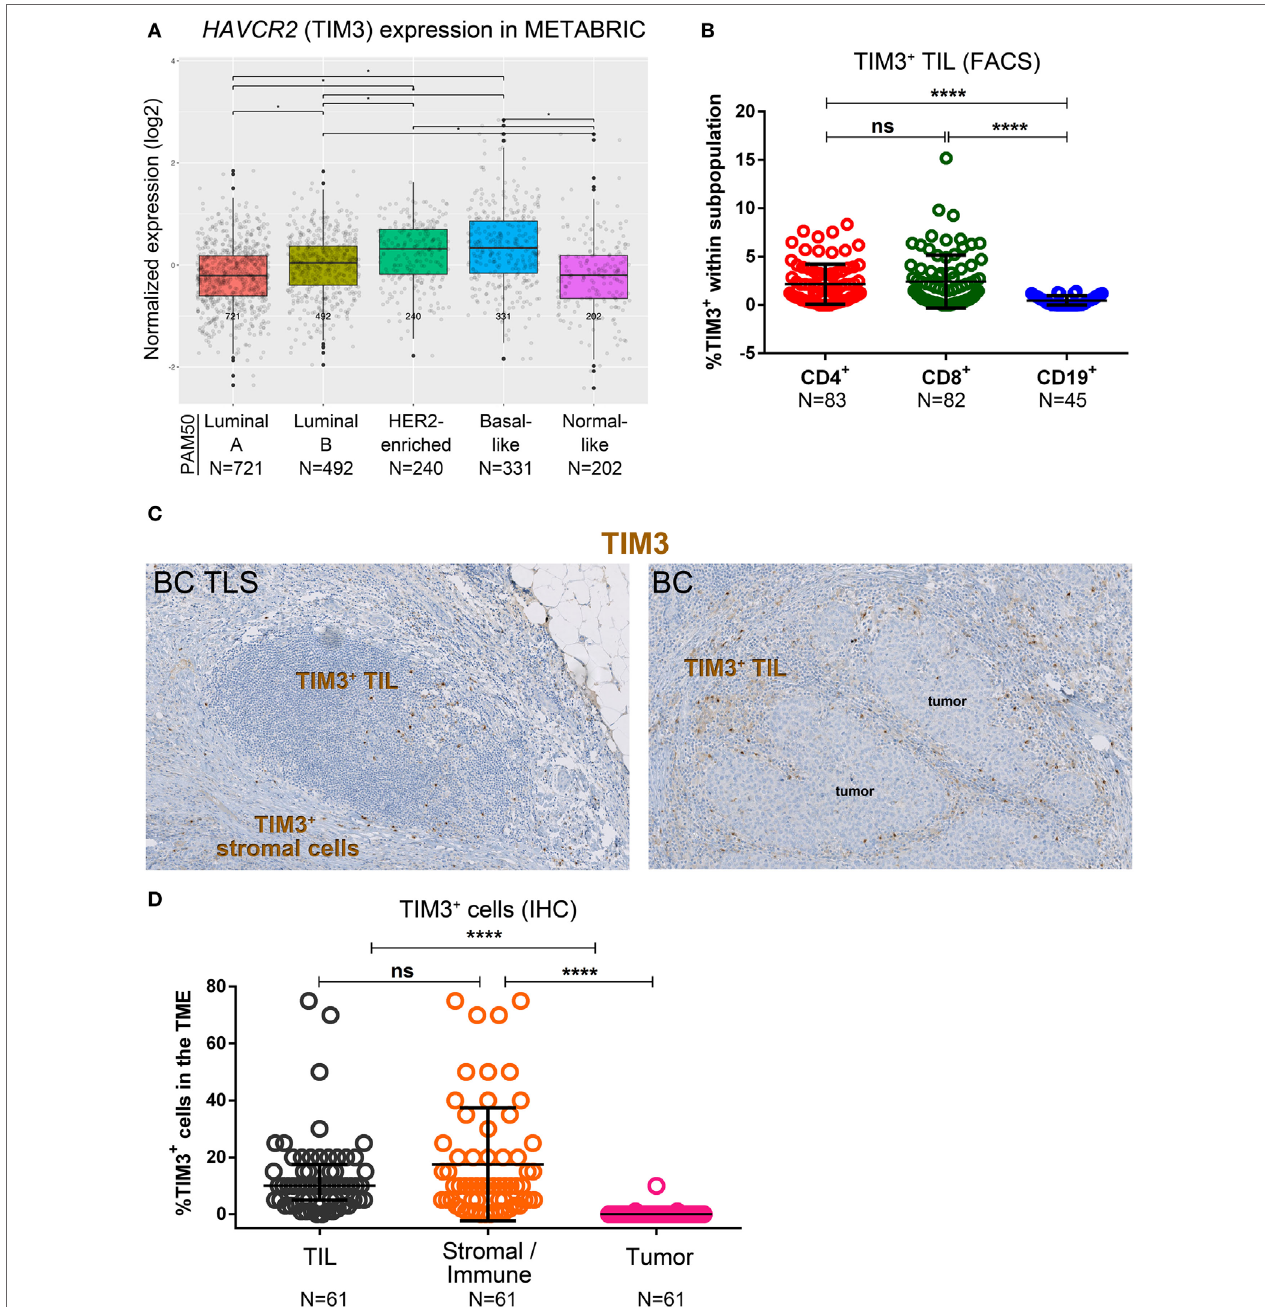
FigUre 6 | Expression of TIM3 in primary breast cancer (BC). (a) Expression of HAVCR2 (TIM3) gene by PAM50 molecular subtypes (microarray data from the METABRIC dataset) (37). Box plots show median ± interquartile range related to log of expression of HAVCR2 (TIM3) gene in different subtypes (Luminal A, Luminal B, HER2-enriched, Basal-like and Normal-like). (B) TIM3 expression by the major subsets (CD4 + , CD8 + , and CD19 + ) of tumor-infiltrating lymphocytes (TIL) isolated from fresh primary breast tumors analyzed by FACS. Bars show mean ± SD. The number of samples included in the analysis ( N ) is based on a minimum number of cells in each TIL subpopulation. (c) TIM3 expression in BC-associated tertiary lymphoid structures (TLS) and in BC TIL and stromal cells by immunohistochemistry (IHC). (D) Expression of TIM3 on stromal cells, tumor cells, and TIL by IHC scored by an immunopathologist. Bars show mean ± SD and **** refers to a P value <